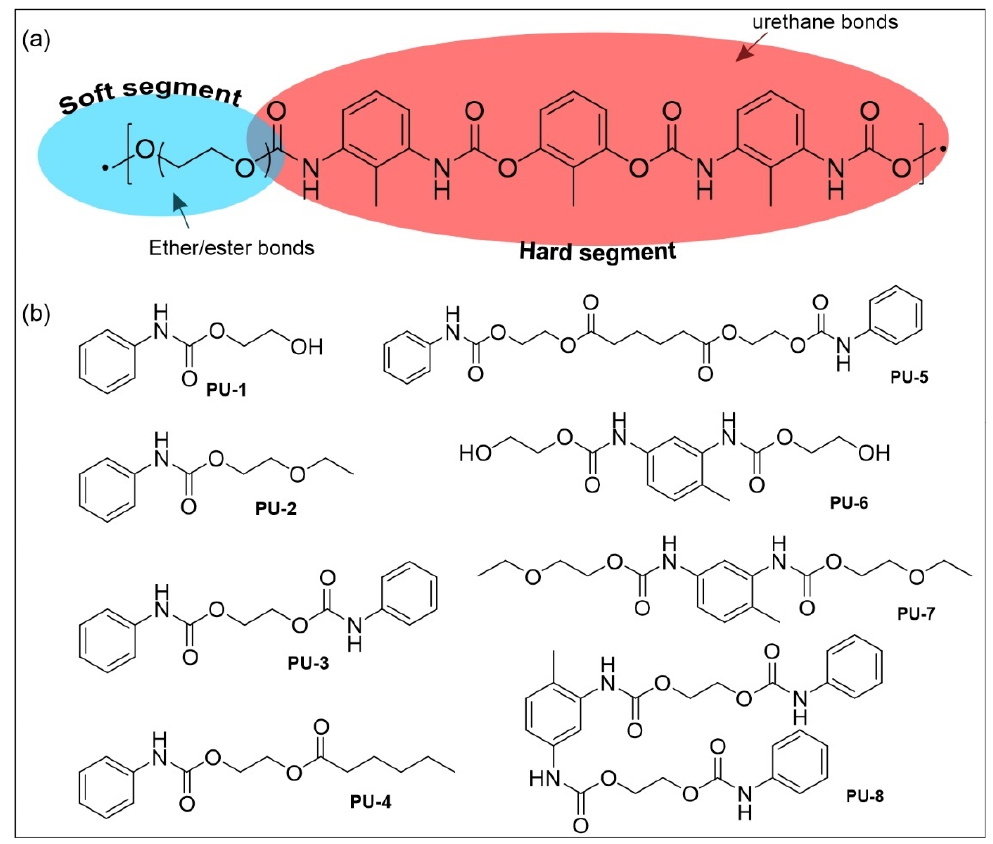
Figure 1. Polyurethane (PU) ( a ) polymer representation; ( b ) proposed model substrates synthesized in this study derived from hydrolysis of PU hard segment and PU ‐ related compounds for detection of novel biocatalysts.